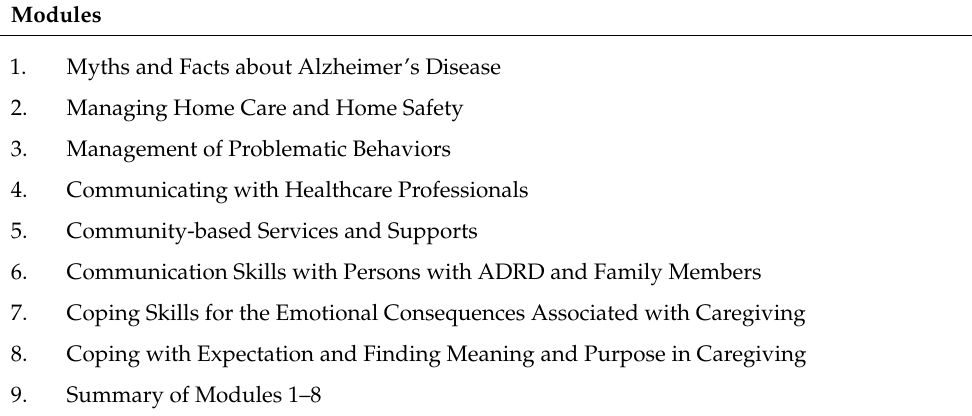
Table 1. The Contents of Senior Companion Plus (SCP Plus) (adapted from Morano & King, 2010